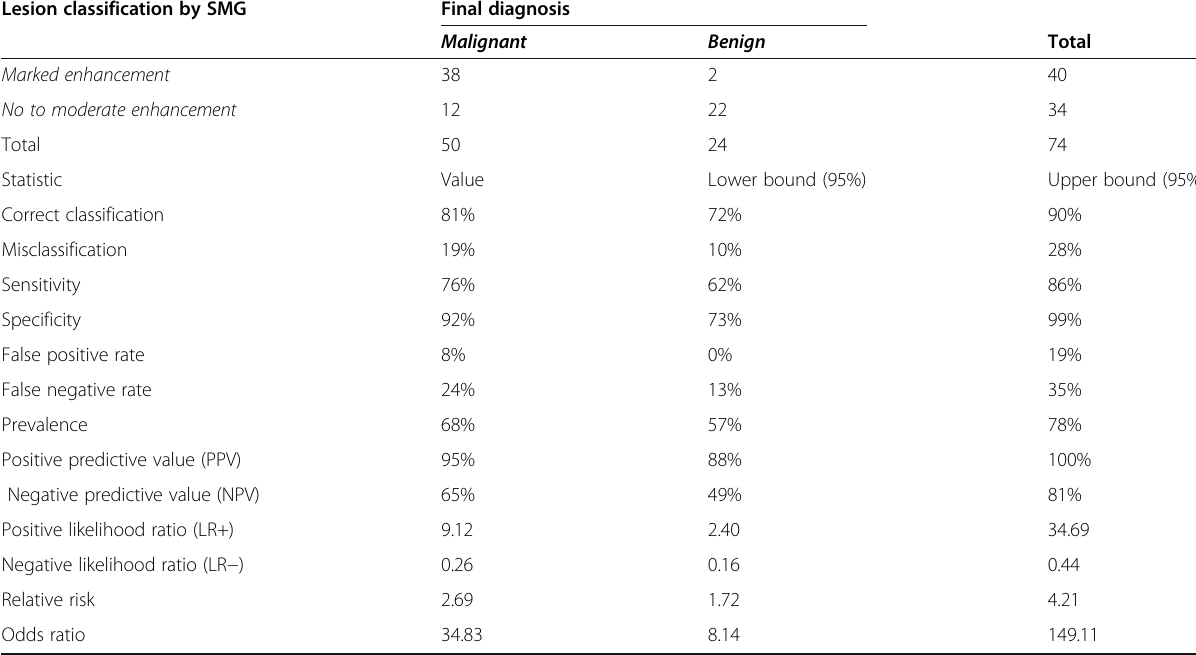
Table 18 Diagnostic accuracy of marked enhancement on CESM in patients with ACR grade C/D Lesion classification by